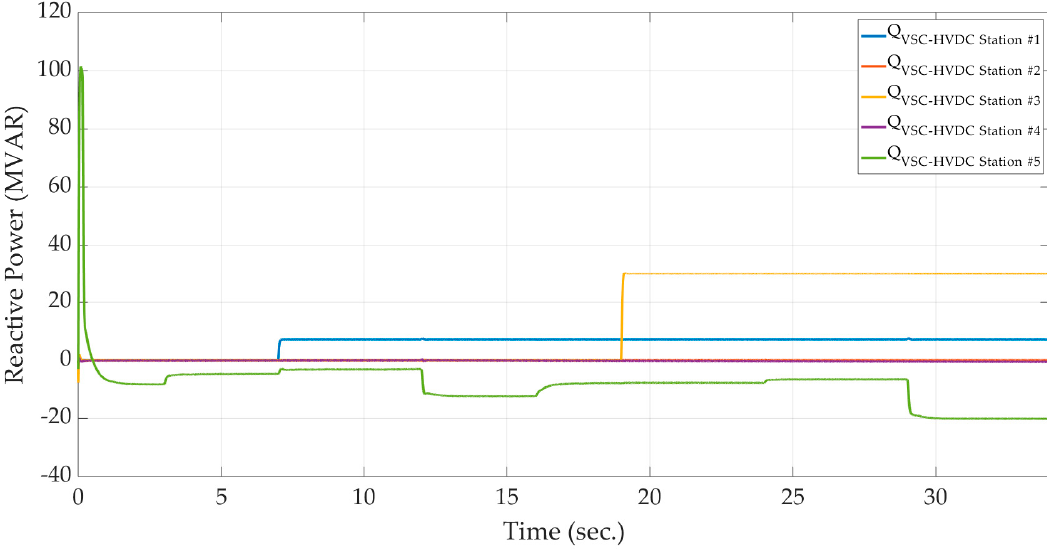
Figure 20. The active power profile of different VSC-HVDC stations in the third scenario.